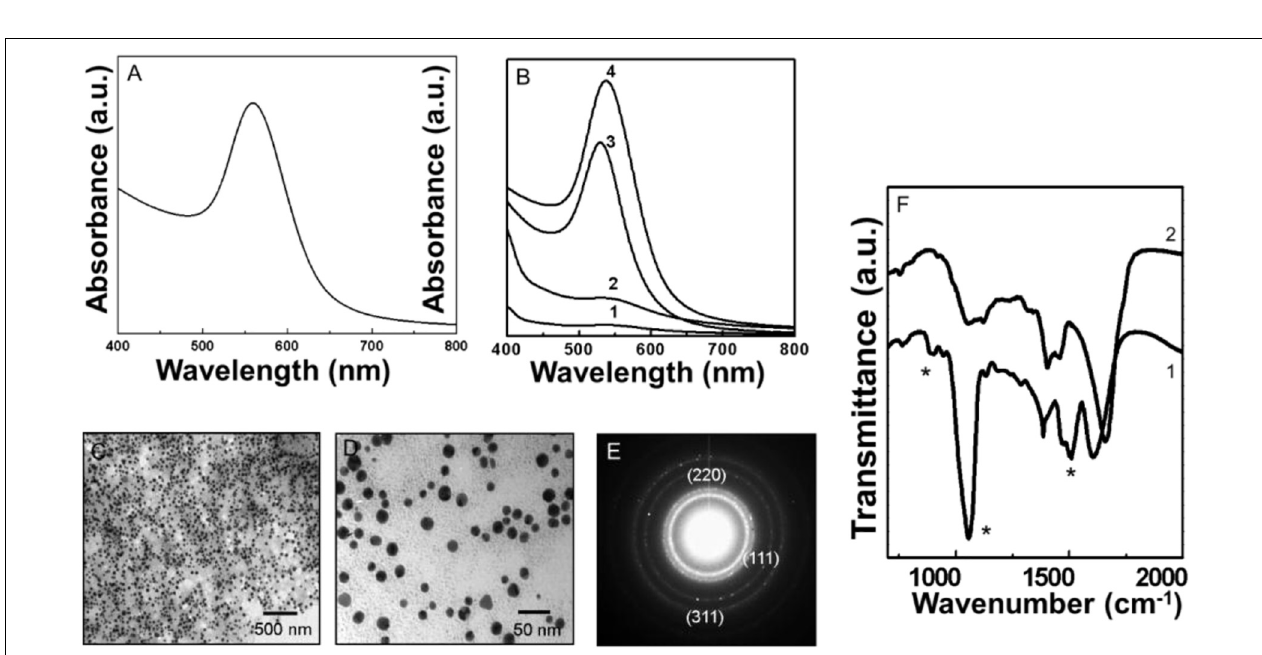
FIGURE 3 | Uv-Vis spectroscopy, transmission electron microscopy (TEM), and Fourier transformed infrared spectroscopy (FTIR) analysis of biologically synthesized Py-AuNPs. (A) The Uv-Vis spectrum of Py-AuNPs synthesized after 60 min of reaction between pyocyanin and silver ions. (B) Pv-AuNPs formation kinetics followed by Uv-Vis absorption spectroscopy. Curves 1 to 4 represent time intervals of 15, 30, 45, and 60 min respectively. (C,D) Representative TEM images of Pv-AuNPs showing the presence of monodisperse spherical nanoparticles. (E) SAED pattern obtained from Pv-AuNs shown in the TEM images. (F) FTIR spectra recorded from pyocyanin before (curve 1) and after (curve 2) the formation of Py-AuNPs. The * sign indicates vibrations from pyoverdine which are significantly affected after the formation of py-AuNPs.